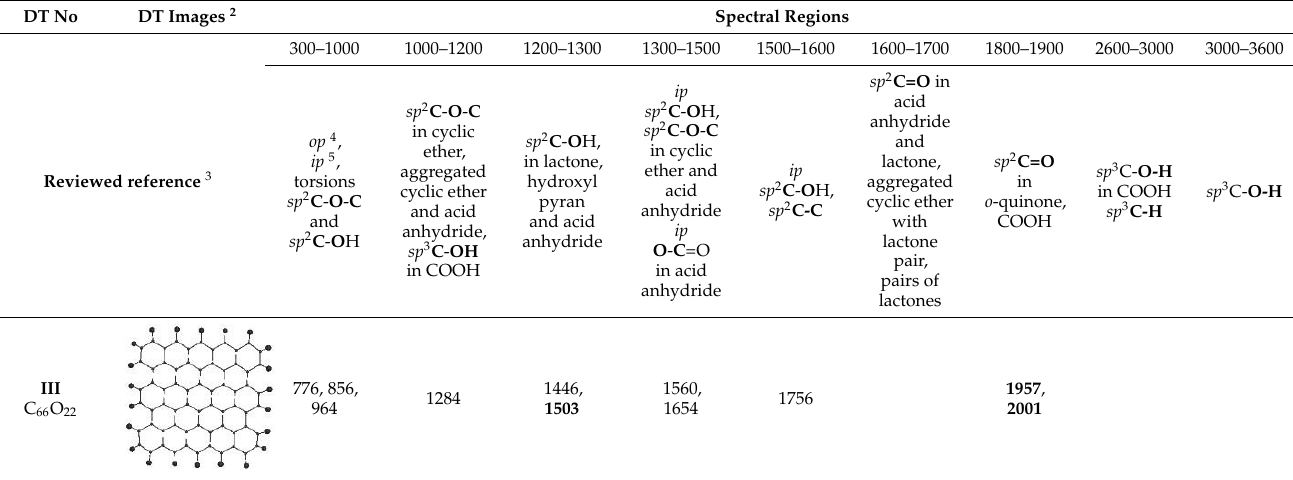
Table 2. UHF general frequencies kits of necklaced graphene oxides, based on IR spectra 1 , cm −1 .